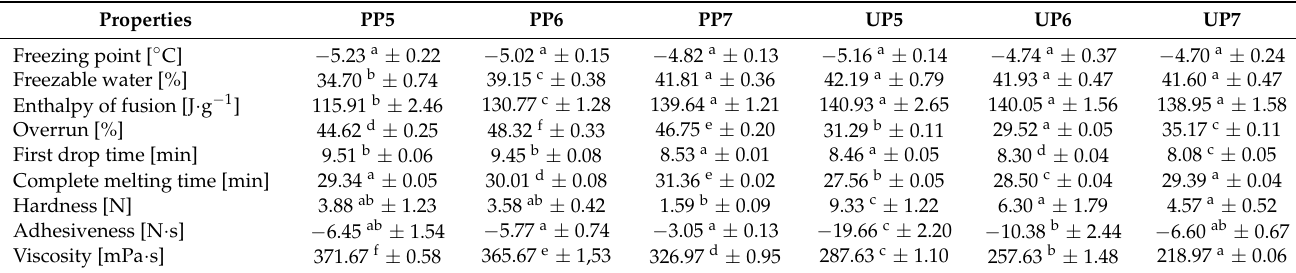
Table 3. Thermal and physical properties of the tested